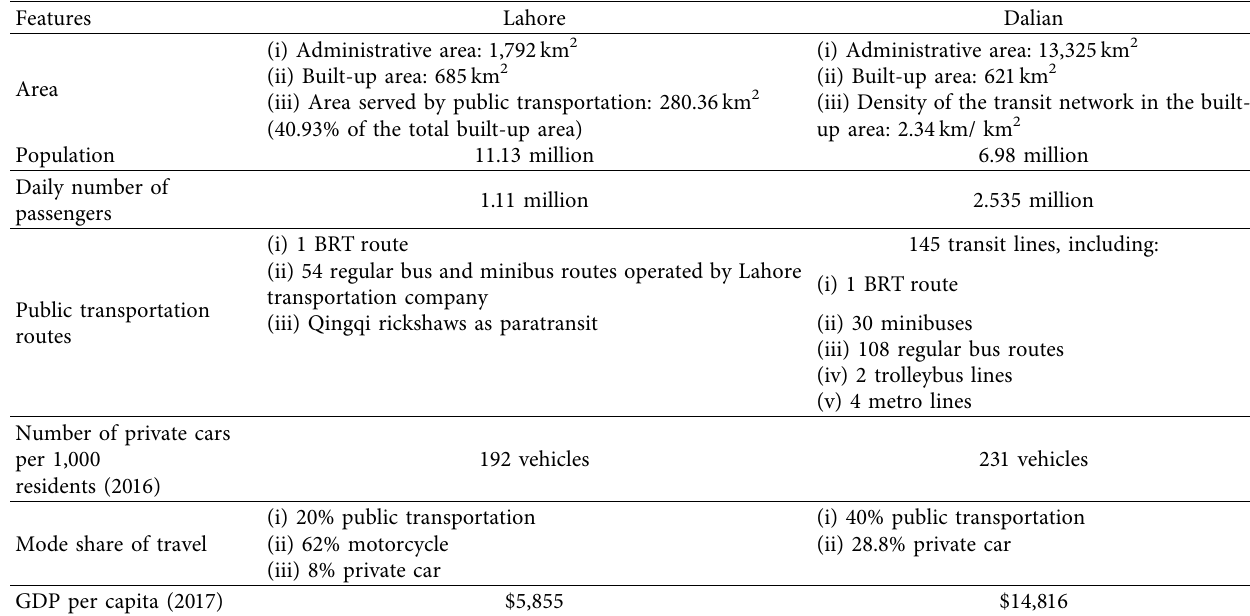
Table 2: Features of Lahore and